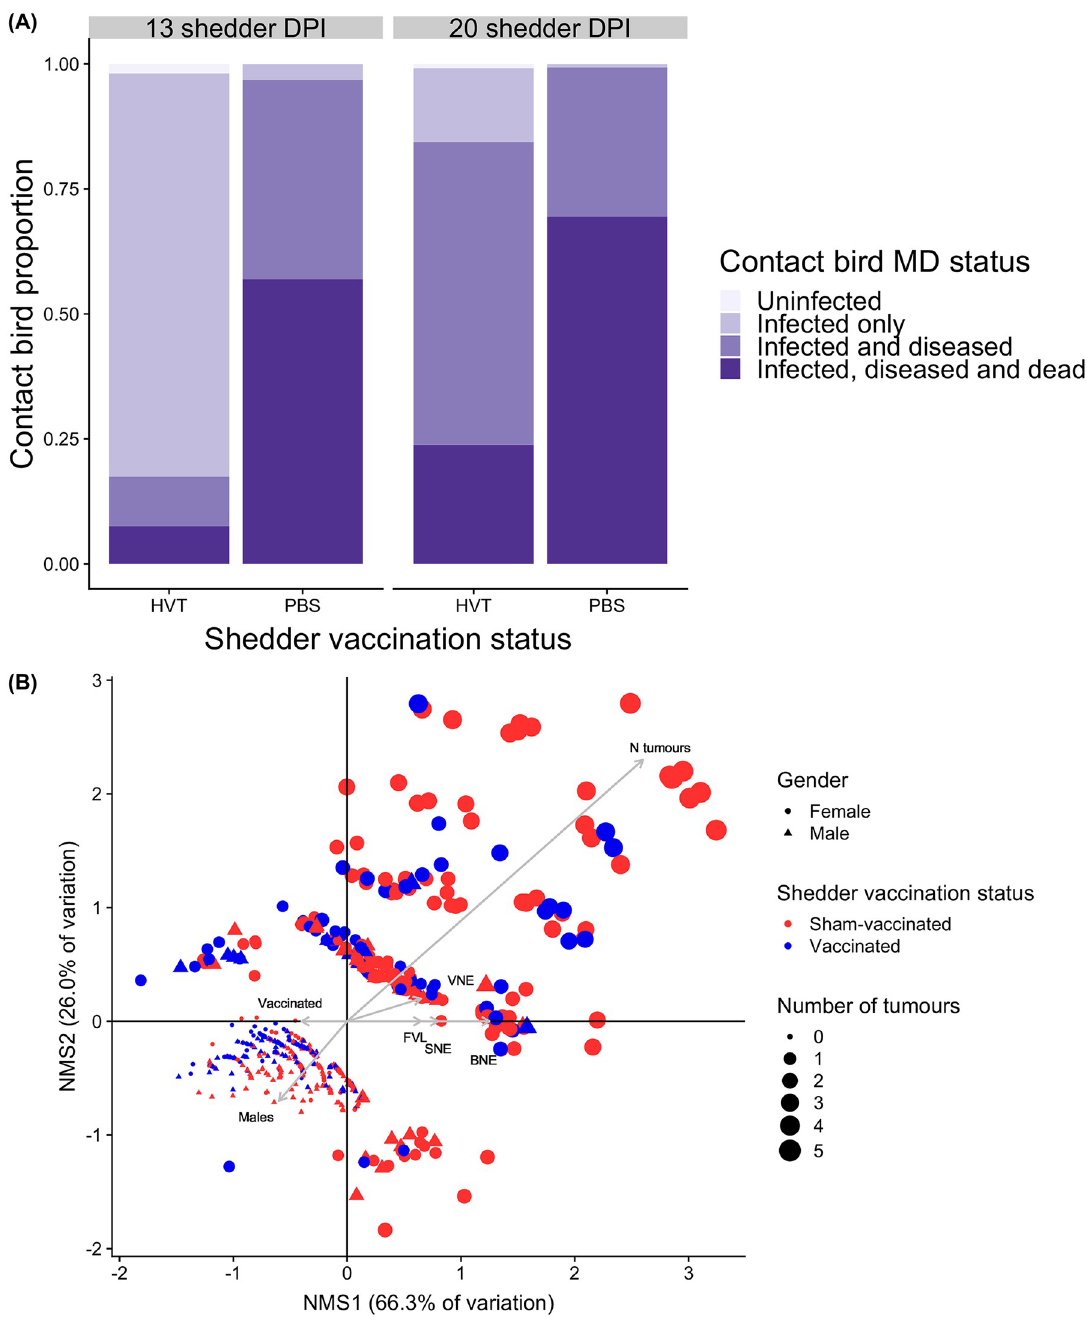
Fig 2. Summary of shedder impacts on contact birds. (A) Impact of shedder vaccination status on contacts at 13 and 20 shedder DPI. Contacts positive for virus in qPCR from samples taken at 14 DPC were classified as infected. ‘Diseased’ individuals showed visible symptoms (peripheral nerve enlargement and/or tumours) at necropsy, 8 weeks post-contact, or upon death. ‘Dead’ contacts were those that died or were humanely euthanized before the end of the 8-week experimental period, were infected, and were positive for disease symptoms at necropsy. HVT = vaccinated shedders; PBS = sham-vaccinated shedders. (B) Nonmetric multidimensional scaling plot, for diseased contacts only, of relationships between contact bird disease severity variables and contact bird sex, shedder vaccination status, and shedder FVL. Points are individual contact birds. Grey arrow distance along each axis represents its nonparametric Kendall’s tau correlation with that axis. Opposite-pointing arrows indicate negative associations. Contacts of vaccinated shedders and males therefore had fewer tumours and less extreme nerve enlargement. Points are clustered from bottom-left to top-right into increasing numbers of tissues with tumours, concordant with changing point size; clustering in other directions indicates qualitatively different combinations of tissues with tumours. Variables differ qualitatively (binary, continuous, or ordinal) and so correlation coefficients and hence arrow